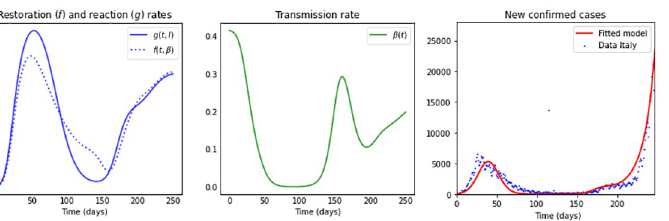
Fig 8. Simulation fitting COVID-19 data from Italy. The first subplot depicts the restoration rate f ( t , β ) (dotted) and reaction rate g ( t , I ) (solid); the second plot the transmission rate β ( t ); and in the third plot the blue dots represent data of daily confirmed new cases of COVID-19 in Italy, from February 24th, 2020, to October 31st, 2020 [61]. The red curve represents the least square fit of the model to the data with parameter values as in Table 3 for the population of Italy, with N = 60.5 million individuals and initial conditions of the model (5) taken to be E 0 = 81, I 0 = 566, R 0 = 0, S 0 = N − E 0 − I 0 − R 0 . The fit produces a root-mean-square error (RMSE) of 1083.49.